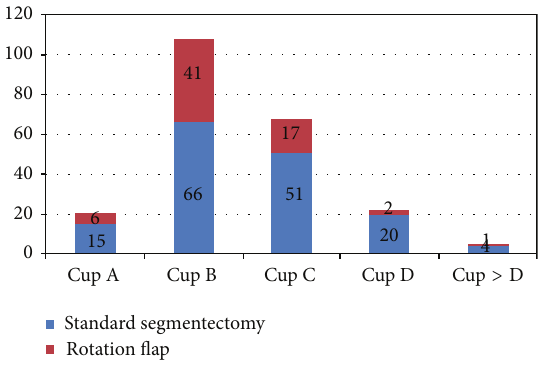
Figure 11: Distribution of brassiere cup